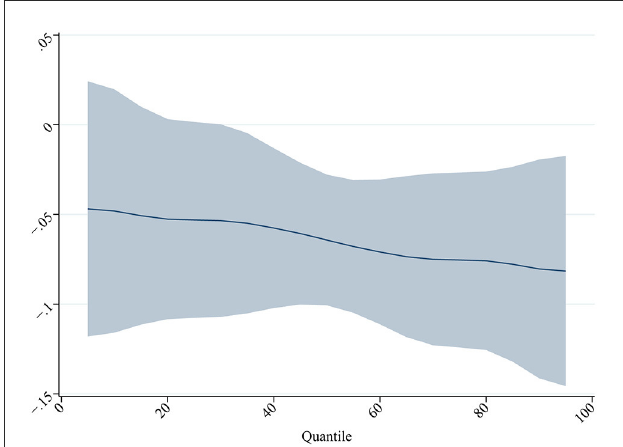
FIGURE3 Effect of LTCI on individuals in different quartiles of MPI. The figure depicts the coefficients as well as the 90% confidence intervals for the regression analysis. Robust standard errors are clustered at the city level. *** , ** , and * denote 1%, 5%, and 10% significance level, respectively. All regressions control for year FE, individual FE, demographic and socioeconomic covariates, and household-level covariates, as specified in Table